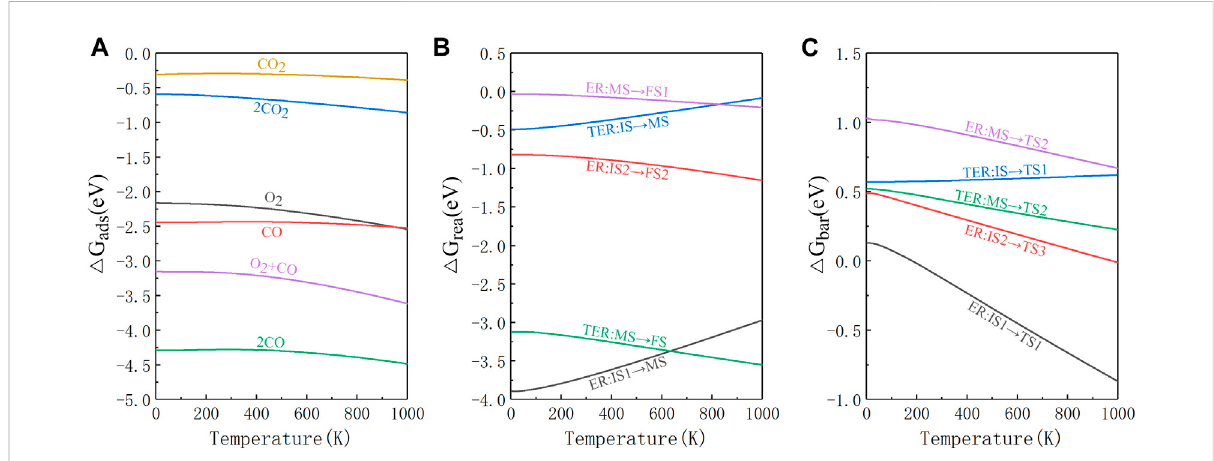
FIGURE 5 The change in Gibbs free energy of each reaction path at 0 – 1000 K. (A) The gas molecules adsorption energy. (B) The energy released by the reaction. (C) The energy barrier required for the reaction.